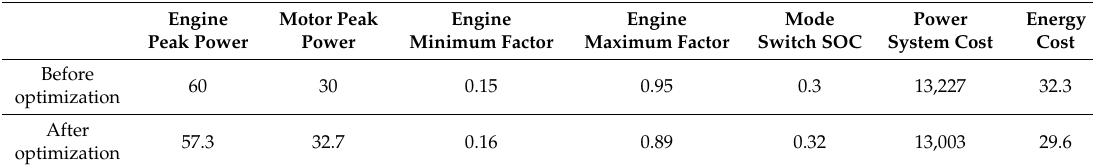
Table 4. Comparison of simulation